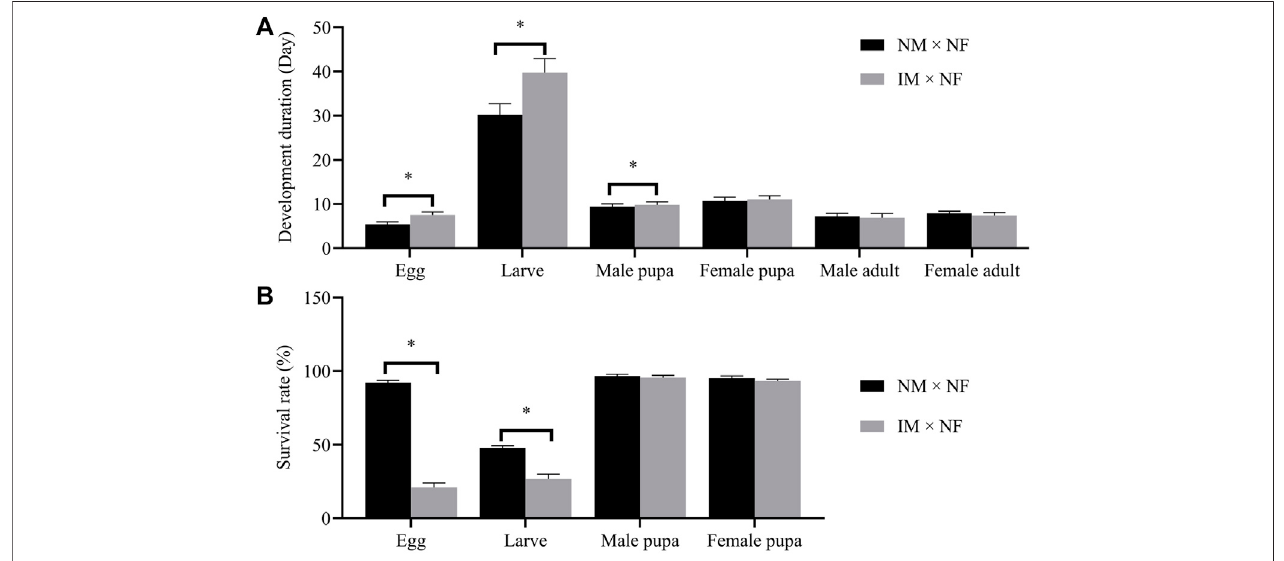
FIGURE 4 | Developmental duration (A) and survival rate (B) of F 1 developmental stages laid in the cross IM × NF compared to in the control cross NM × NF. Error bars represent the SD from the mean of three independent replicates. Asterisks indicate signi fi cant differences with p -value < 0.05 compared to the control group.